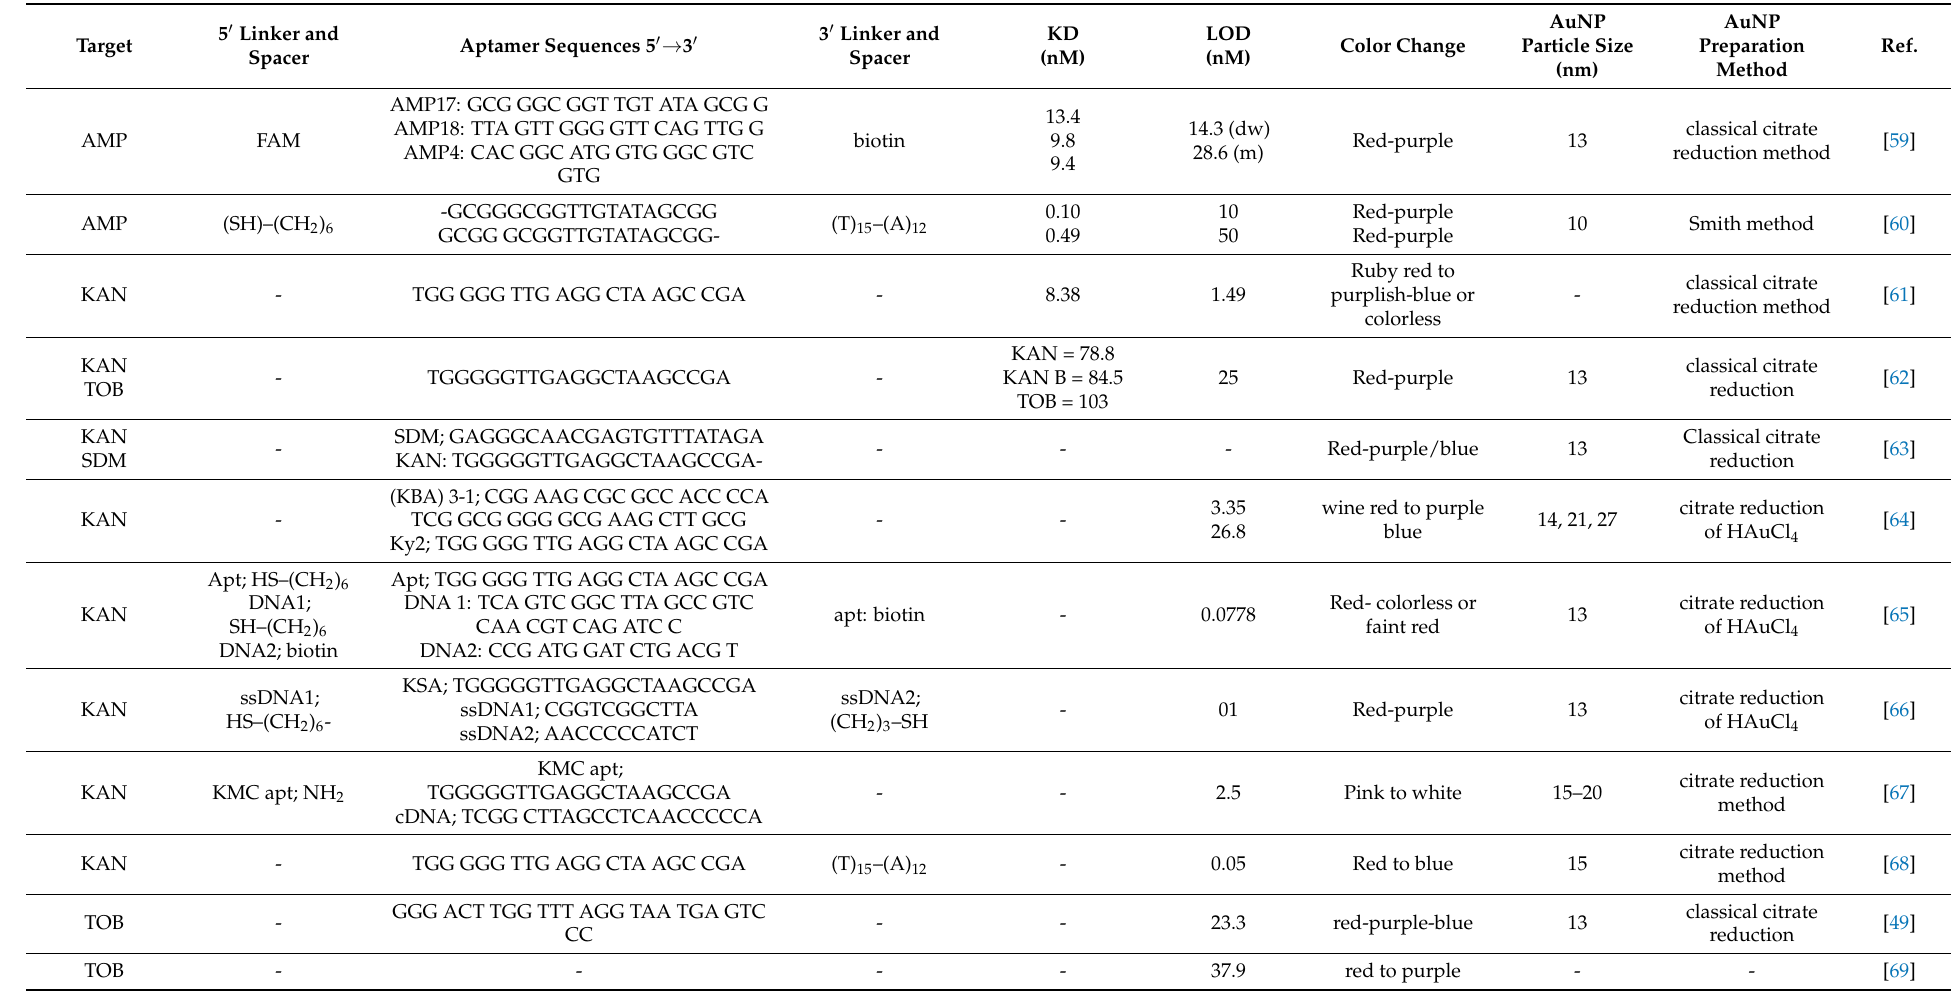
Table 2. Summary of important parameters/results for each method discussed (aptamer sequence, linker and spacers, dissociation constant ( K d ) , limit of detection (LOD), color change in the presence or absence of target, AuNPs particle diameter and preparation methods for each method, mentioned in the corresponding references